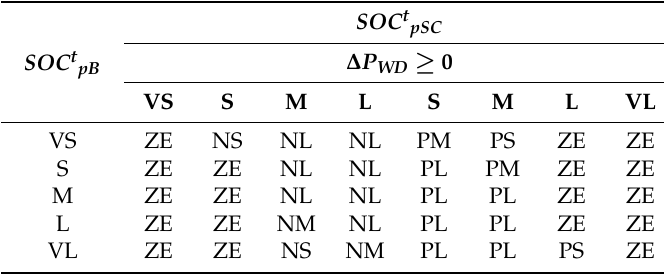
Figure 3. Membership function: ( a ) battery; ( b ) supercapacitor for ∆ P WD ≥ 0; ( c ) supercapacitor for ∆ P WD < 0; ( d ) fuzzy control output. Table 1. Fuzzy control rule. SOC: state of charge.